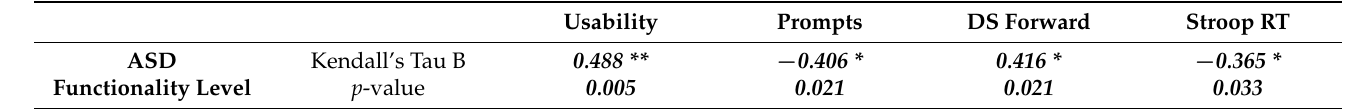
Table 4. Significant Kendall’s Tau correlations with ASD functionality